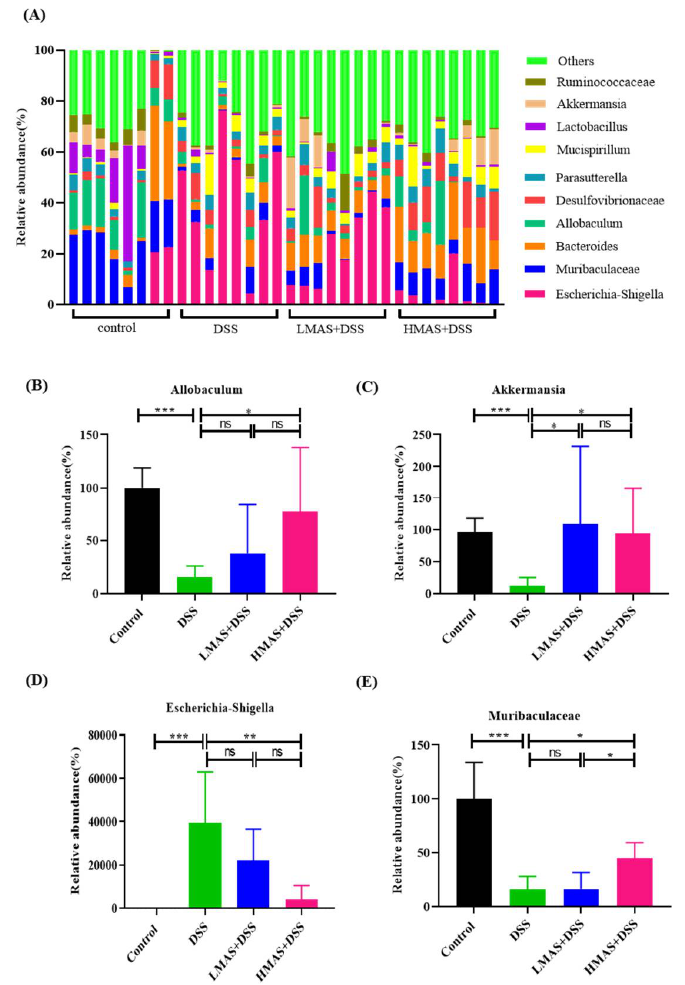
Figure 6. MAS regulates the gut microbiota composition at the genus level. ( A ) Histogram of the relative abundance of genera among the different groups. ( B – E ) MAS regulated Allobaculum , Akkermansia , Escherichia-Shigella , and Muribaculaceae . Here, ns = not significant. Data are shown as the mean ± SD. * p < 0.05, ** p < 0.01, *** p < 0.001, in comparison with the DSS group (n =